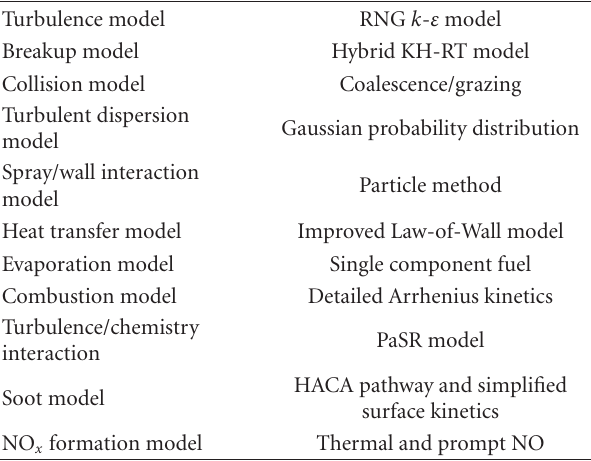
Table 4: The computational submodels encoded in the KIVA3V, Rel. 2 code.